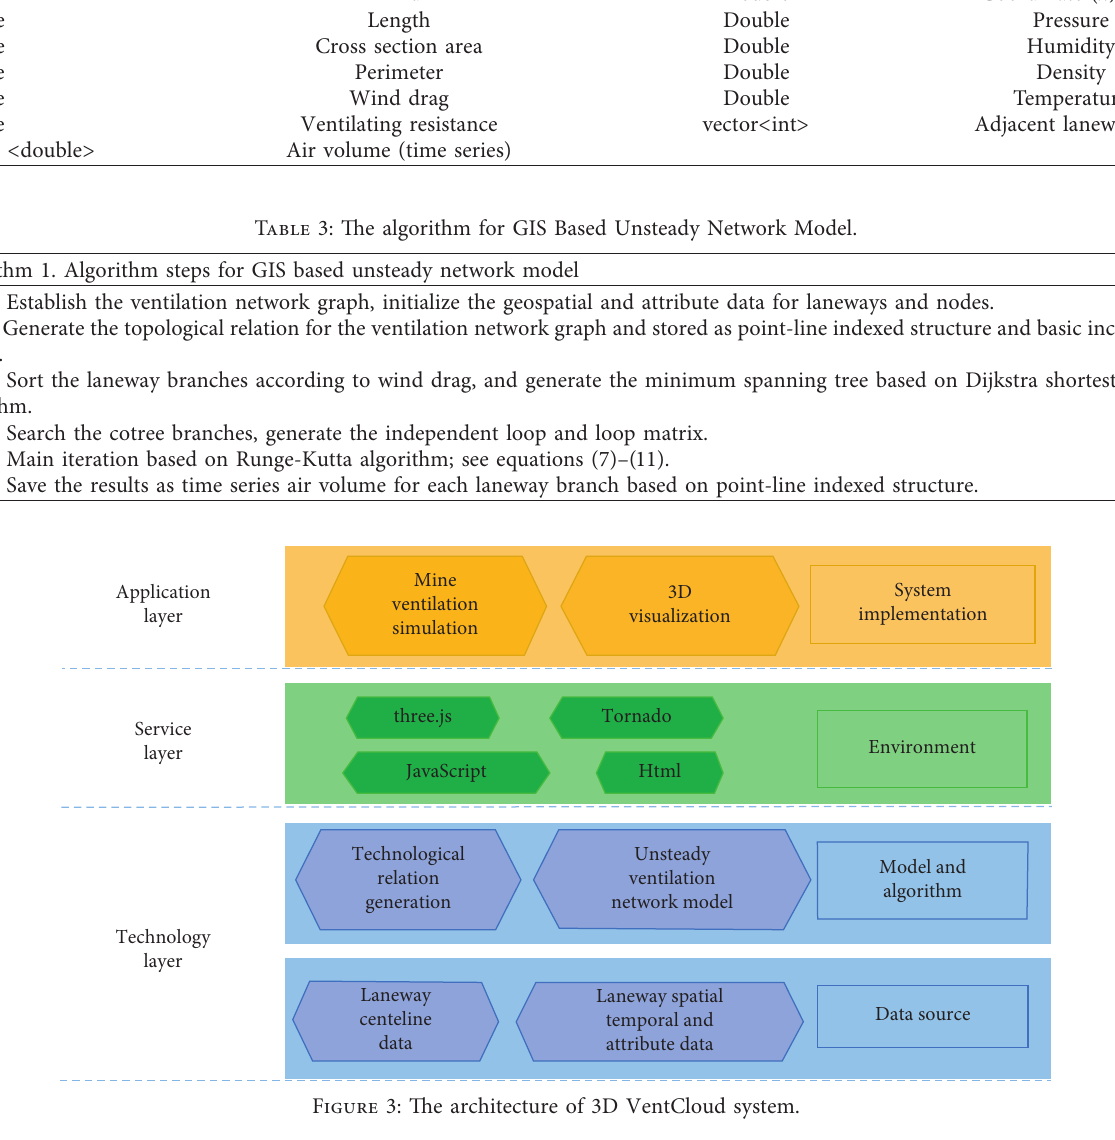
Figure 4. The network diagram has 11 laneway branches